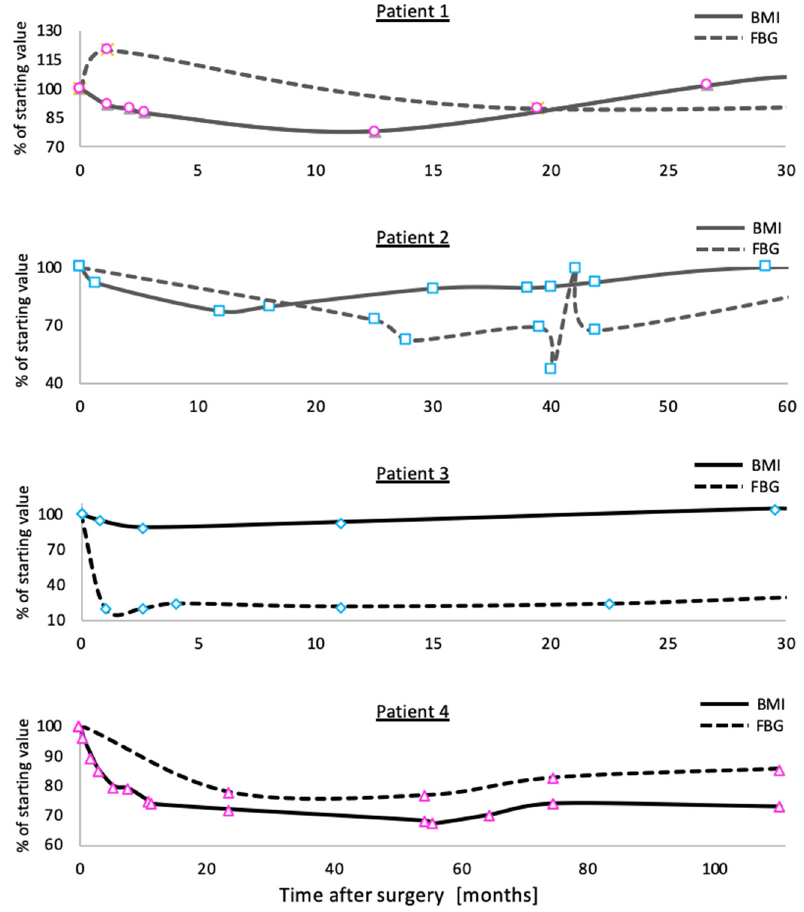
Figure 3. Percentage of BMI (full lines) and fasting blood glucose (FBG, dashed lines) in homozygous patients presented in this study from surgery to full weight regain ( patients 1 – 3 ). Patient 4 did not regain weight. Patients 2 , 3 had hyperglycemia before surgery. Color coded as in Figure 2: LSG, dark gray; LRYGB, black. Female patients are denoted in pink markers, while male patients are denoted in light blue.